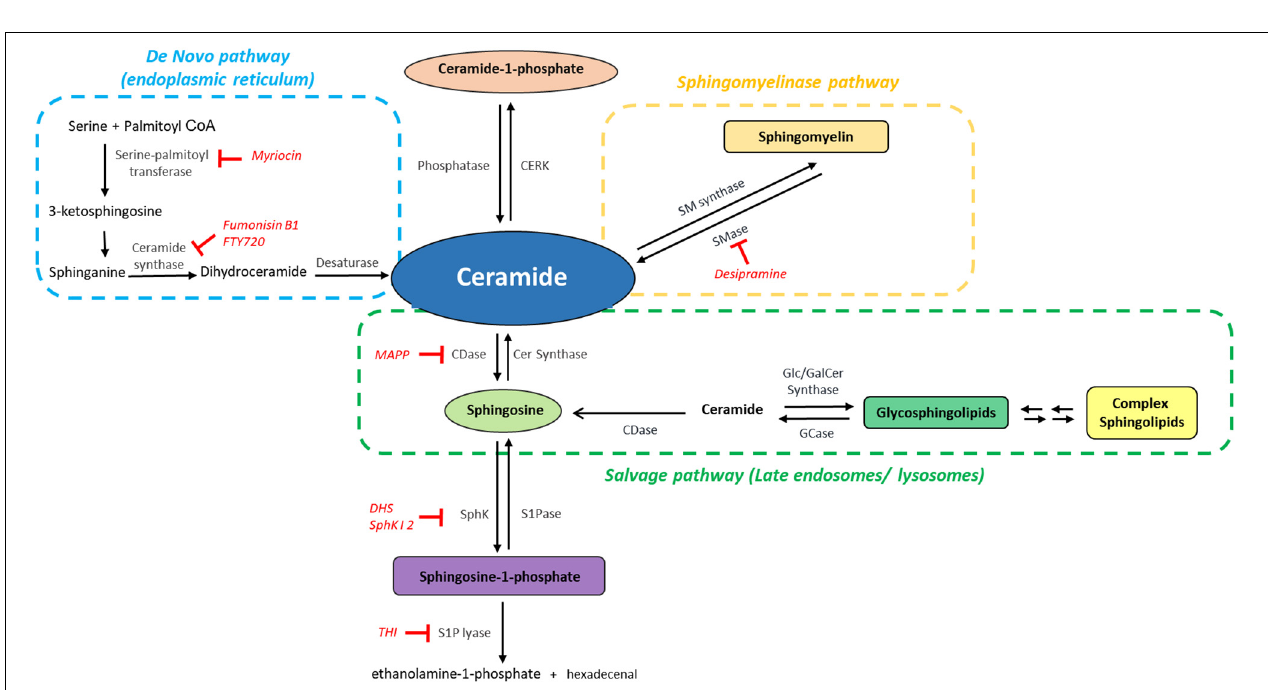
FIGURE 1 | Chemical structures of sphingolipid molecules. The structures of different sphingolipid types are shown. All sphingolipids share a sphingosine backbone (black). This sphingoid backbone is amide-linked to a fatty acid moiety (blue).